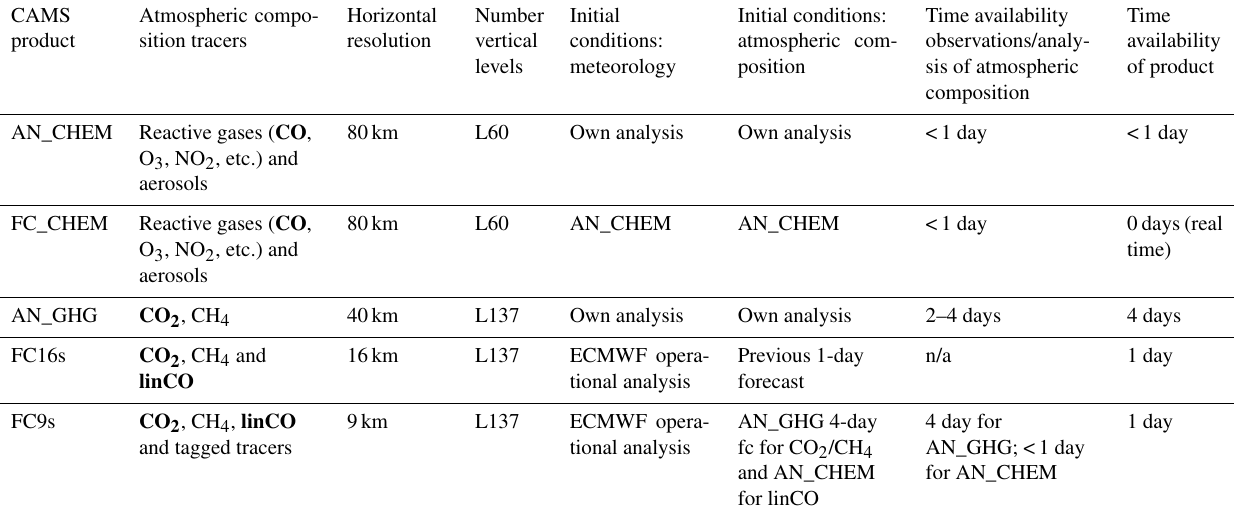
Table 1. Configuration of CAMS global atmospheric composition products valid during the period of the Korea-United States Air Quality (KORUS-AQ) field campaign (May to June 2016). The tracers evaluated in this paper are highlighted in boldface. Time availability is in number of days with respect to real time (n/a is used when this is not